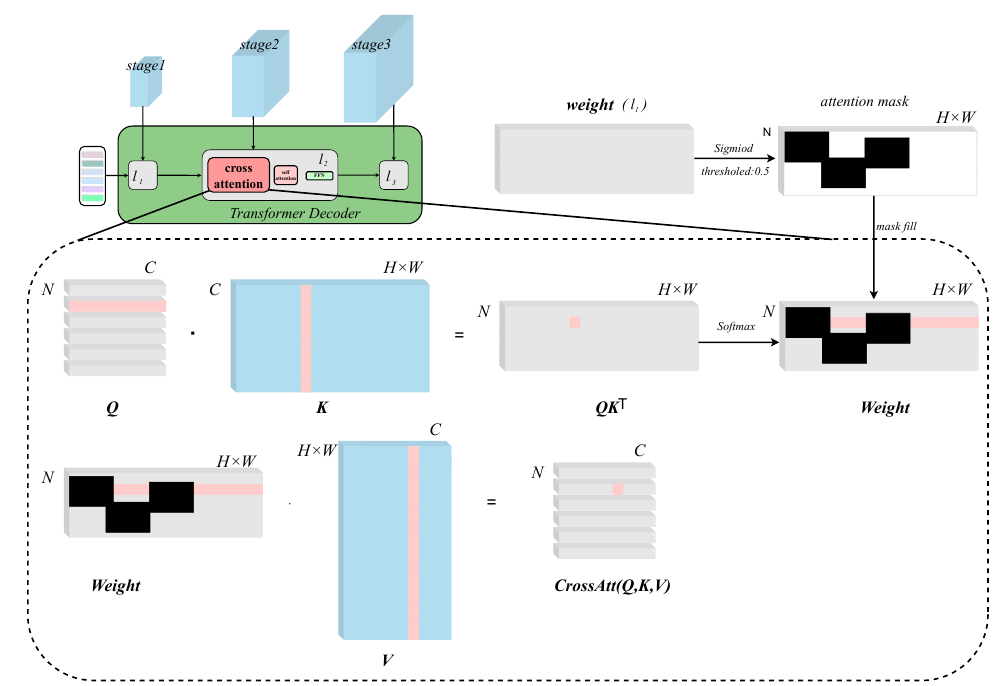
Figure 5. Illustration of the decoder cross-attention with an attention mask. Here, Q = f Q ( A l − 1 ) ∈ R N × C and A 0 denote input object embedding queries to the transformer decoder. K = f K ( x i ) ∈ R H l W l × C ; V = f V ( x i ) ∈ R H l W l × C , f K ( · ) and f V ( · )